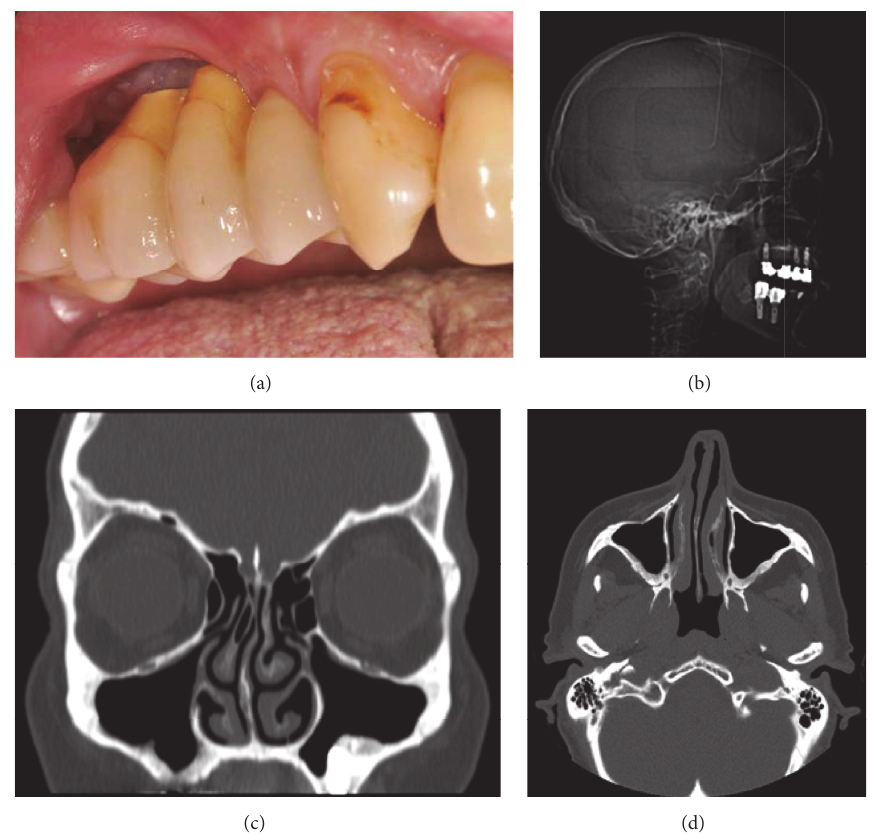
Figure 4: (a) Clinical view of the healed surgical area. (b) Lateral cephalogram without any sign of the foreign body into the sinus. (c, d) The CT scans show normal mucosal thickness and no opacification of the right maxillary